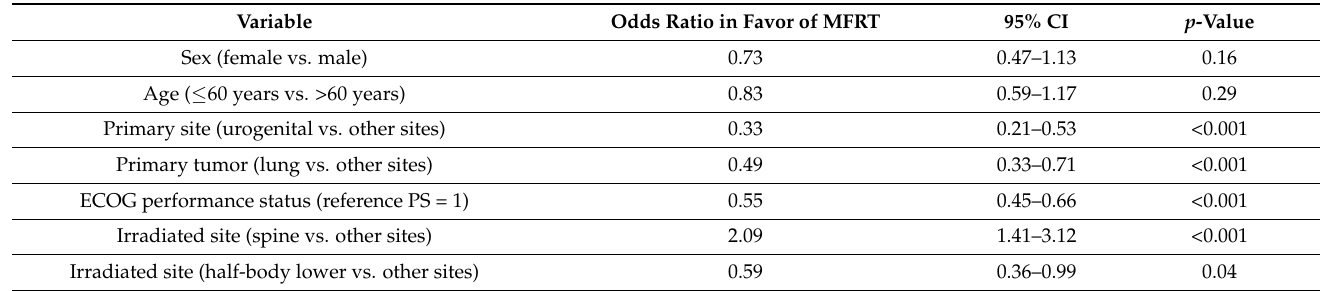
Table 5. Multivariate regression of factors influencing the choice of the irradiation